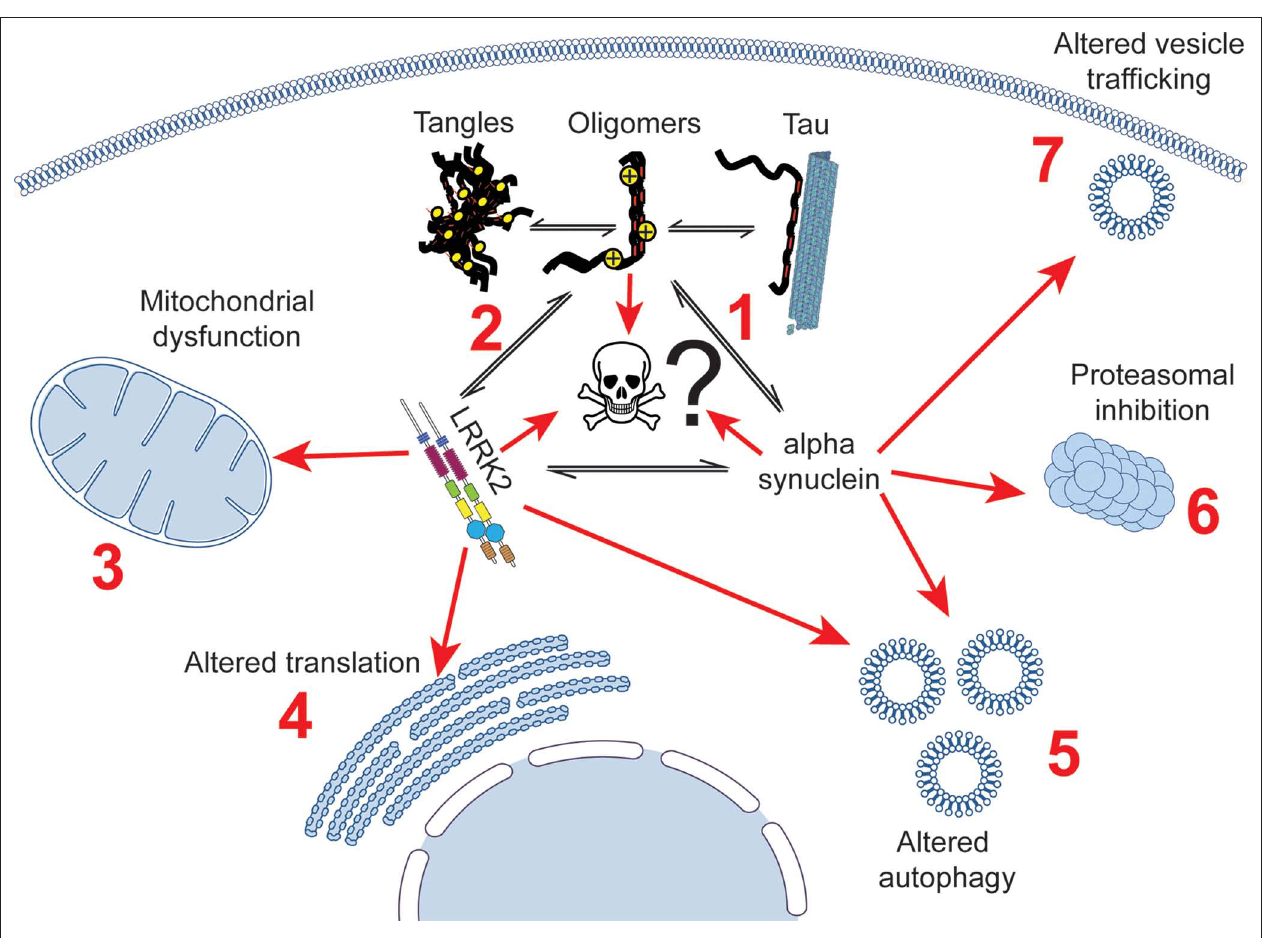
FIGuRe 1 | Potential interactions linking tau to cell death in Parkinson’s disease patients, showing established links between tau, LRRK2, α -synuclein and cellular dysfunction. Tau has been shown to alter the aggregation of α -synuclein (1), and has been described as being aggregated in mouse models of LRRK2 disease (2). A putative cellular interaction